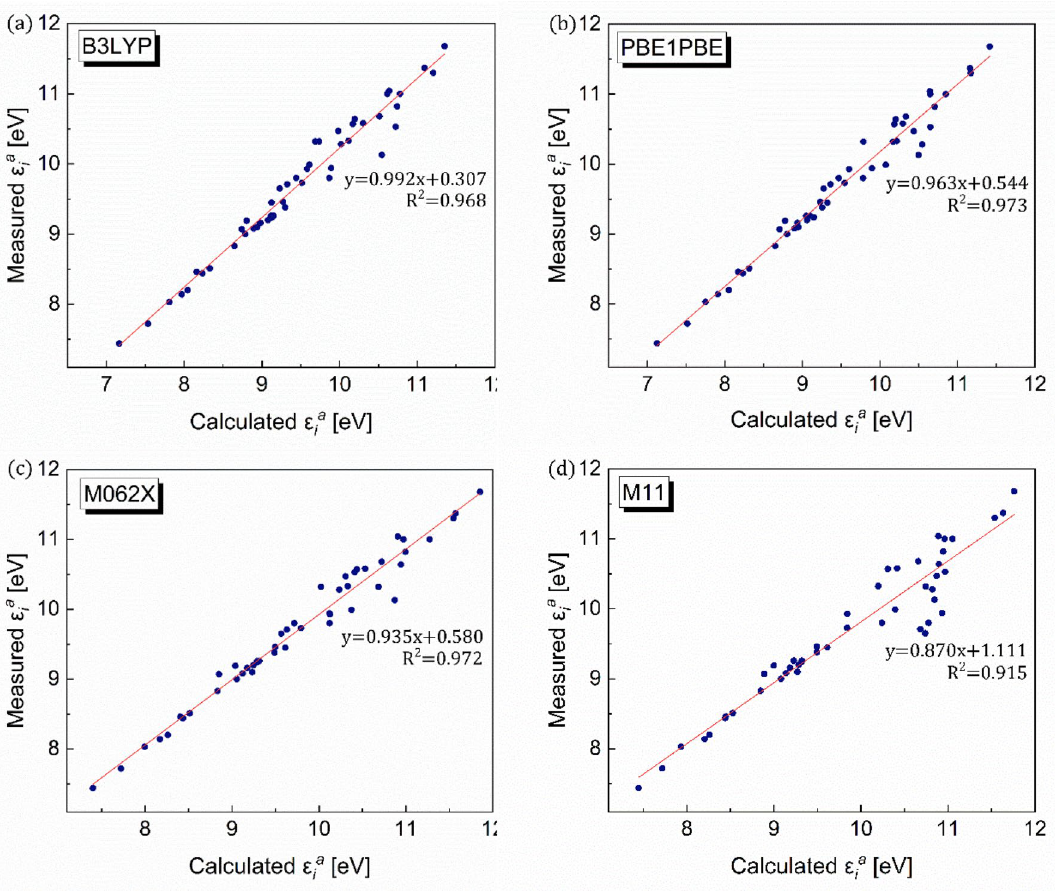
Figure 3. Validation of DFT method for ionization energy. Comparisons between DFT-computed and a measured ionization energy ( ε i ) values for four different DFT functionals, viz . ( a ) B3LYP, ( b ) PBE1PBE, ( c ) M062X, and ( d )